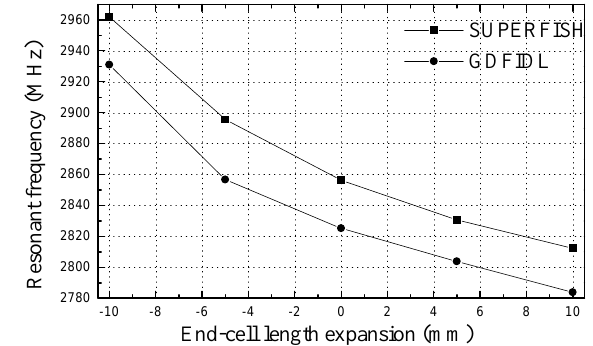
FIG. 5. Structure length effect on resonant frequency of the PWT linac